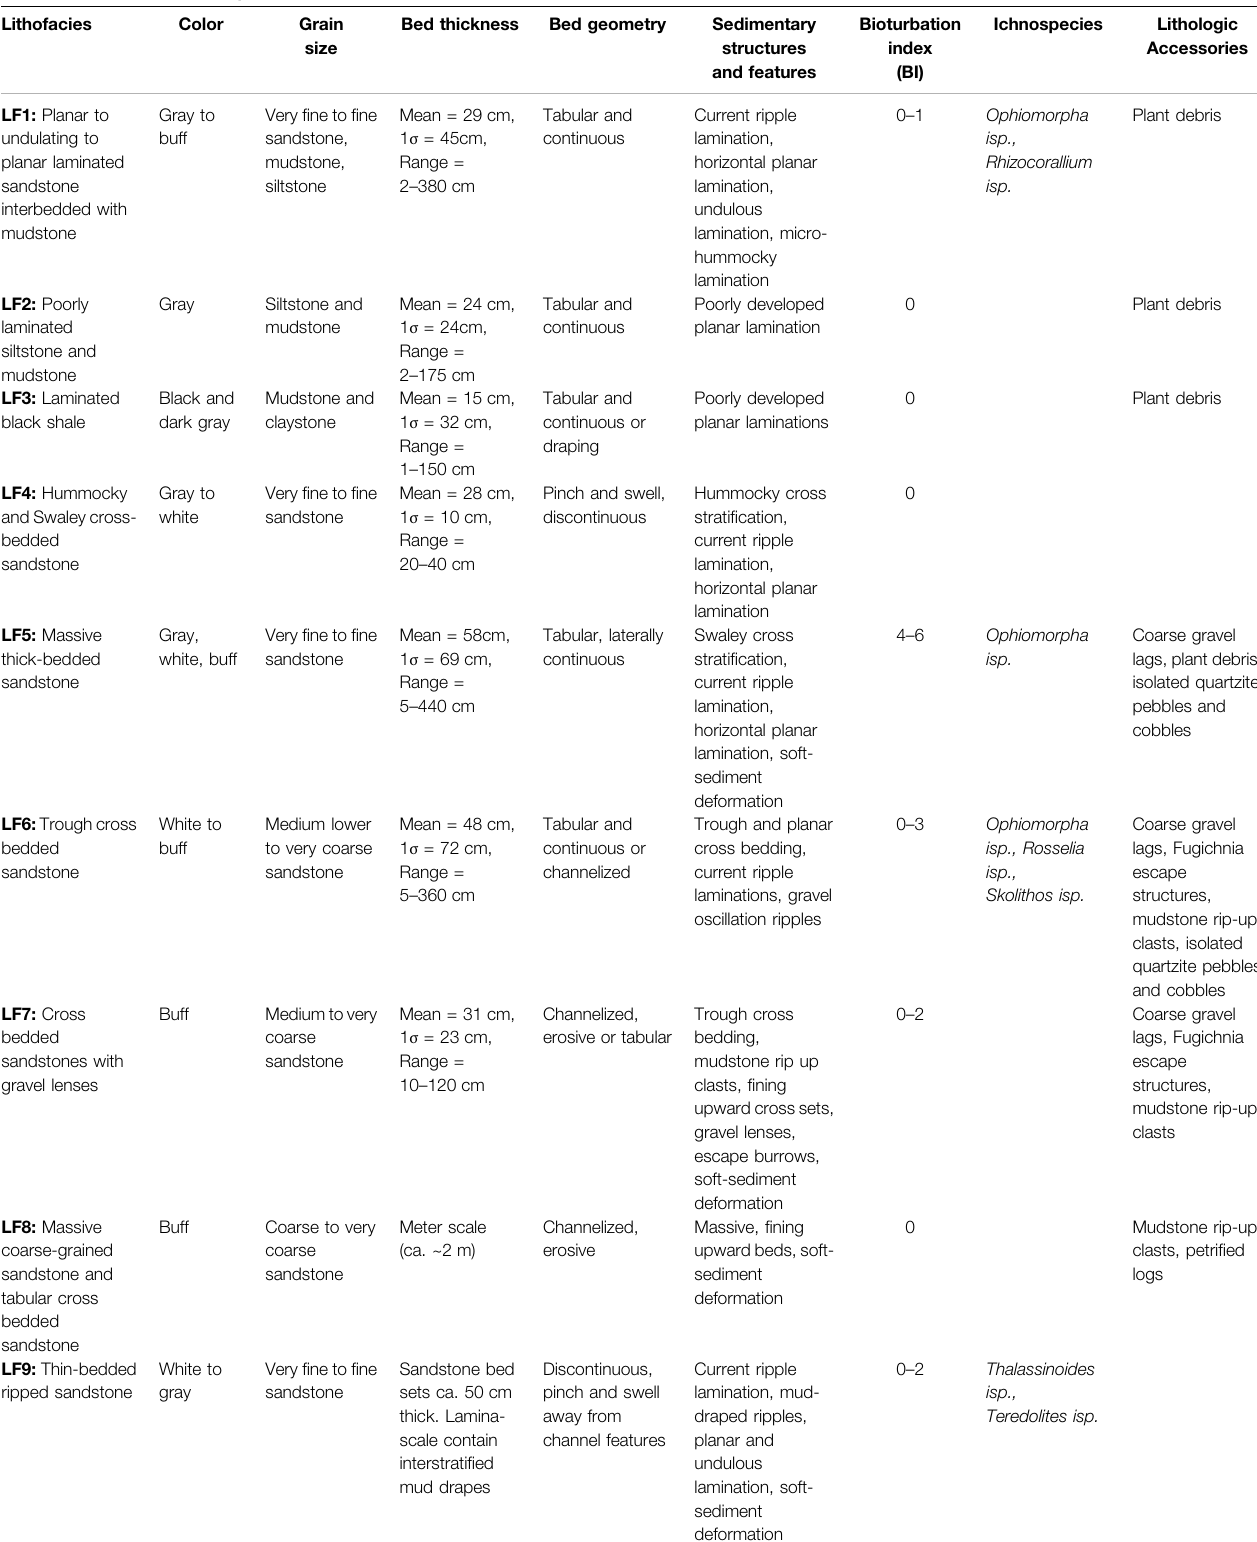
TABLE 1 | Lithofacies and lithofacies association descriptions from the La Anita Formation. TABLE 1A Lithofacies